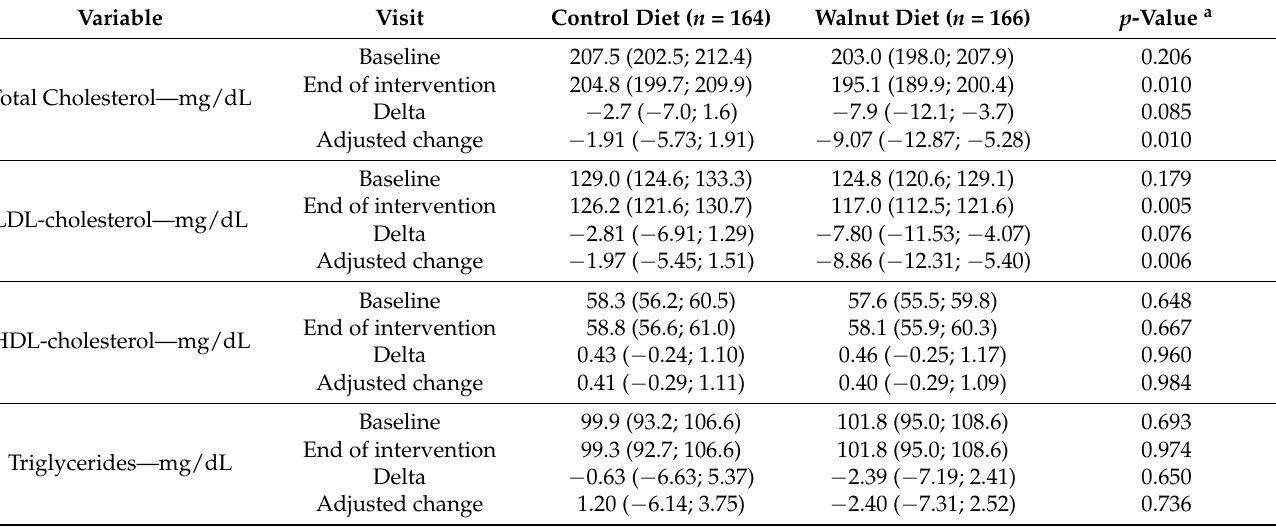
Figure 2. Baseline biomarker of adherence to walnuts and change after one year by intervention. RBCs, red blood cells. ( A ) proportion of alpha-linolenic acid (expressed as percentage of total fatty acids) in RBCs at baseline; p obtained by one-way analysis of variance. ( B ) Change in alpha-linolenic acid in RBCs after 1 year, calculated as percent at 1 year minus percent at baseline; p obtained by one-way analysis of variance. Table 2. Baseline fasting lipids and one-year changes by intervention group.